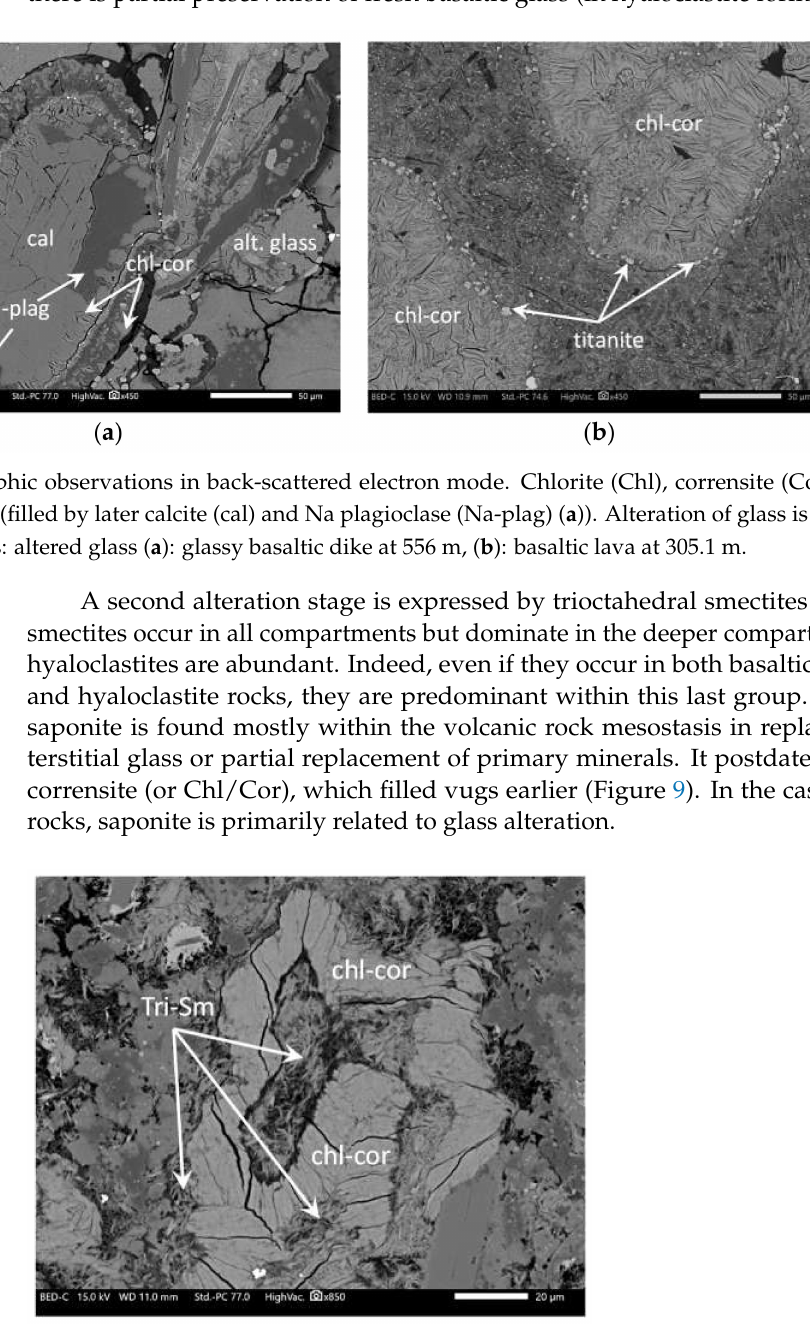
Figure 9. SEM petrographic observations in back-scattered electron mode. Saponite (Tri-Sm) postdat- ing chlorite (chl) and corrensite (cor) or Chl/Cor. Basaltic lava at 405